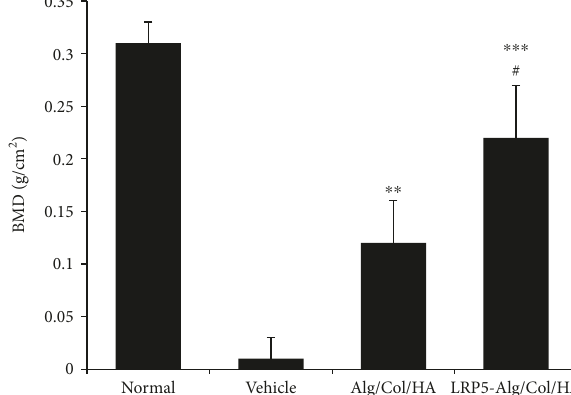
Figure 6: E ff ect of LRP5-Alg/Col/HA on bone mineral density (BMD) in defect sites of a rat model of calvarial critical defect after 6 weeks ’ treatment. ∗∗ P < 0 01 and ∗∗∗ P < 0 001 indicates the comparison with the vehicle group and # P < 0 05 indicates comparison with the Alg/Col/HA